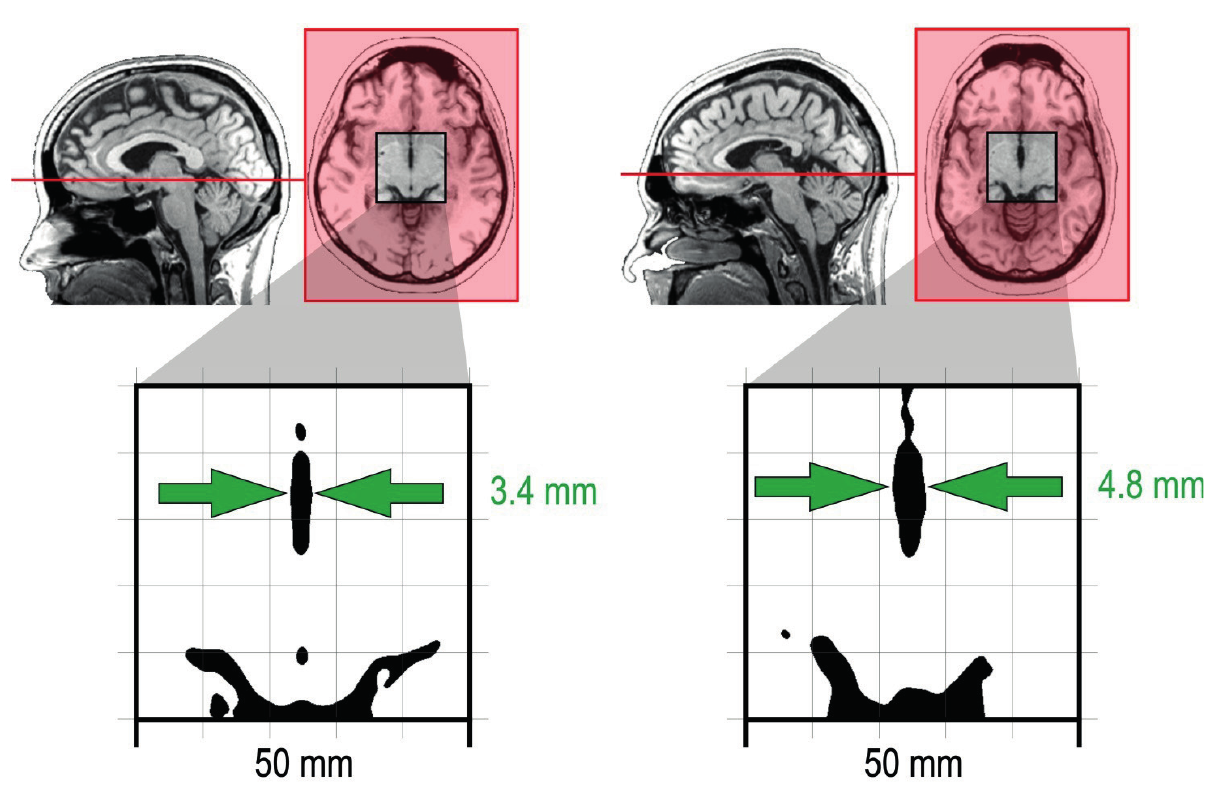
Fig. 1C. Measurements were performed using fully automated in-house software with 0.1 mm linear resolution. In each subject, T1-weighed MP-RAGE dataset was reoriented to AC–PC plane and the trans-axial slice 2 mm below the anterior commissure was selected. After denoising, up-sampling, and segmentation of the images, 3VW was defined as the maximum transverse dimension of 3VW between tuberal regions of HYP.